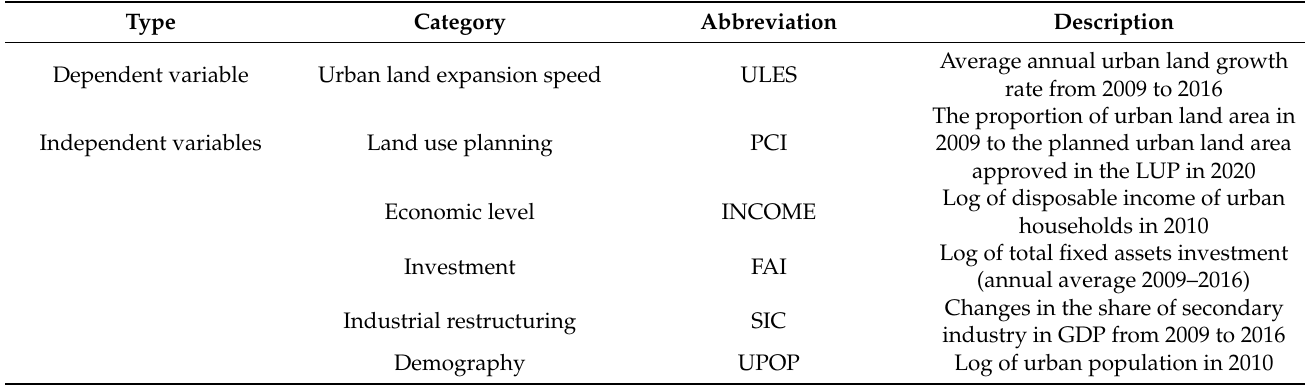
Table 1. Variables.